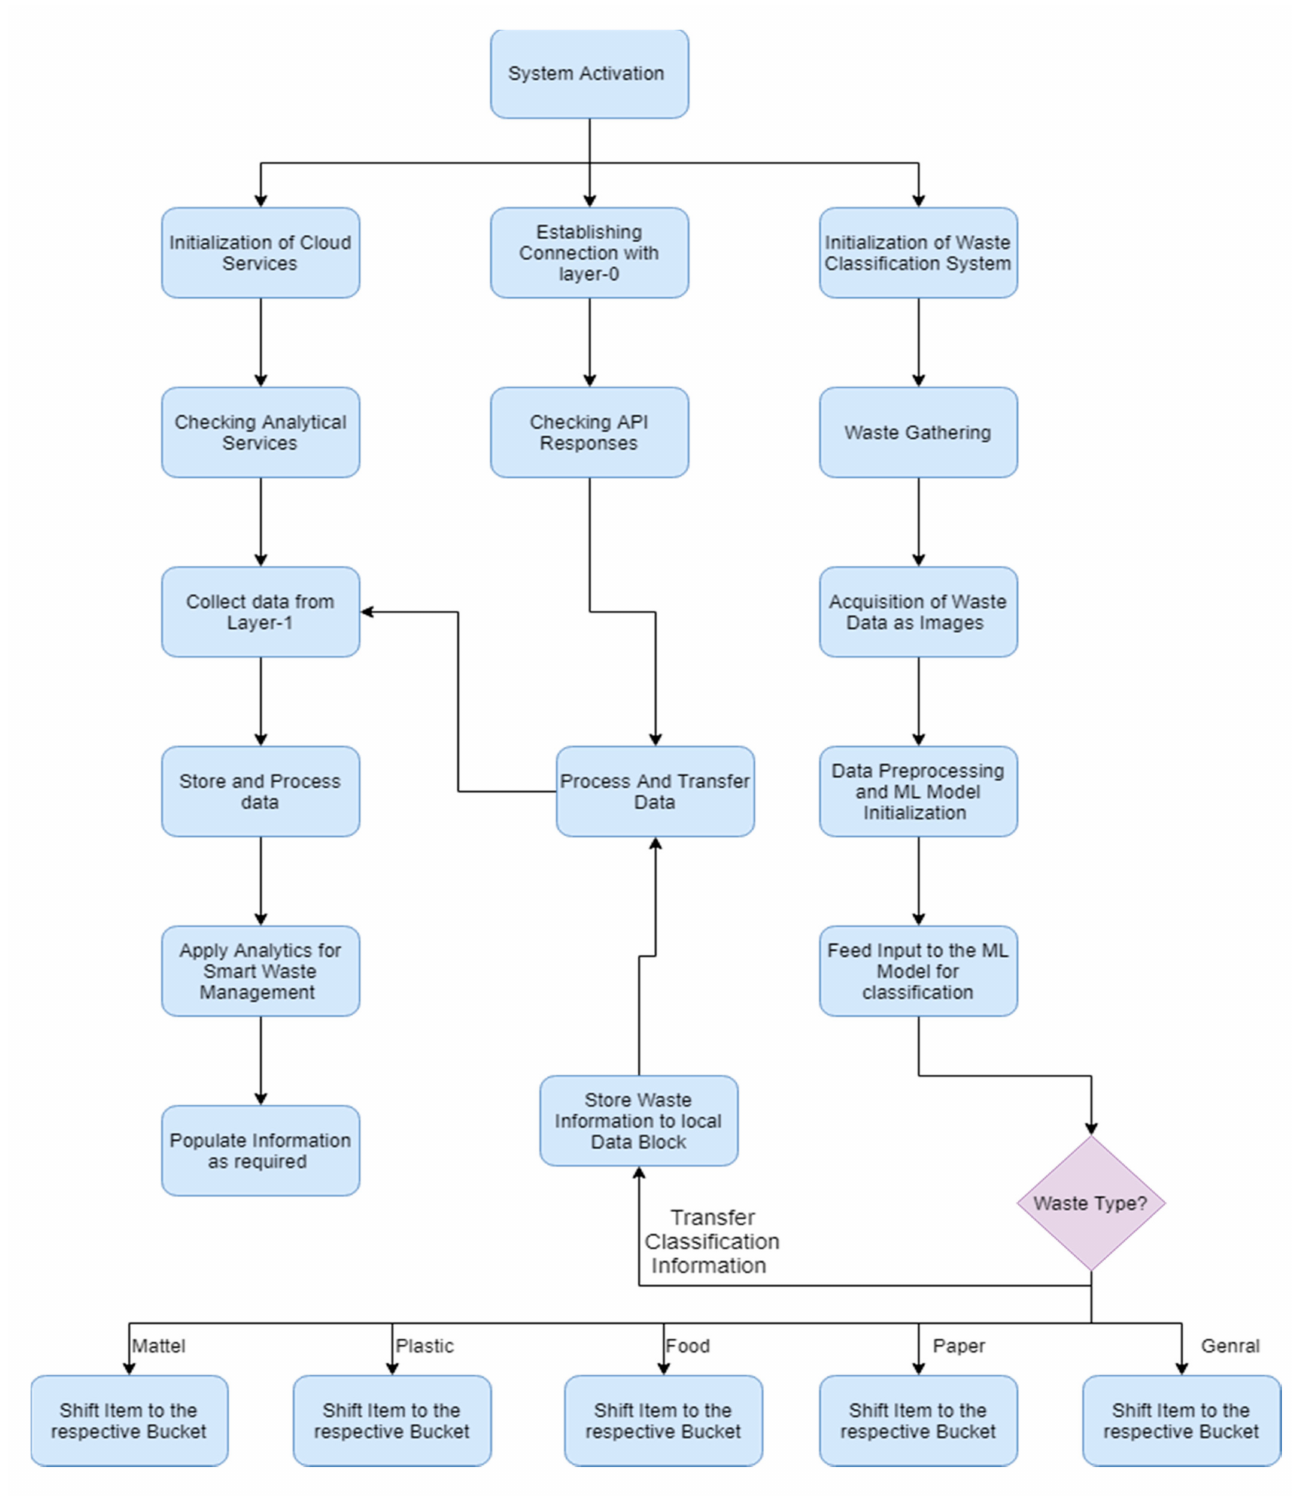
Figure 7. Experimental and system flow